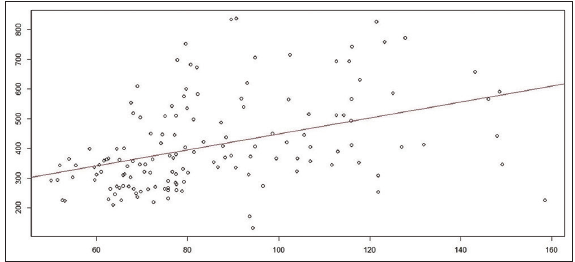
FIGURE 8. Regression line showing the tendency of the linear regression results of the maximum hand grip strength (Y-axis) unit is in Newton and the body weight unit is in kilograms of ages between 10 and 35 years (X-axis).